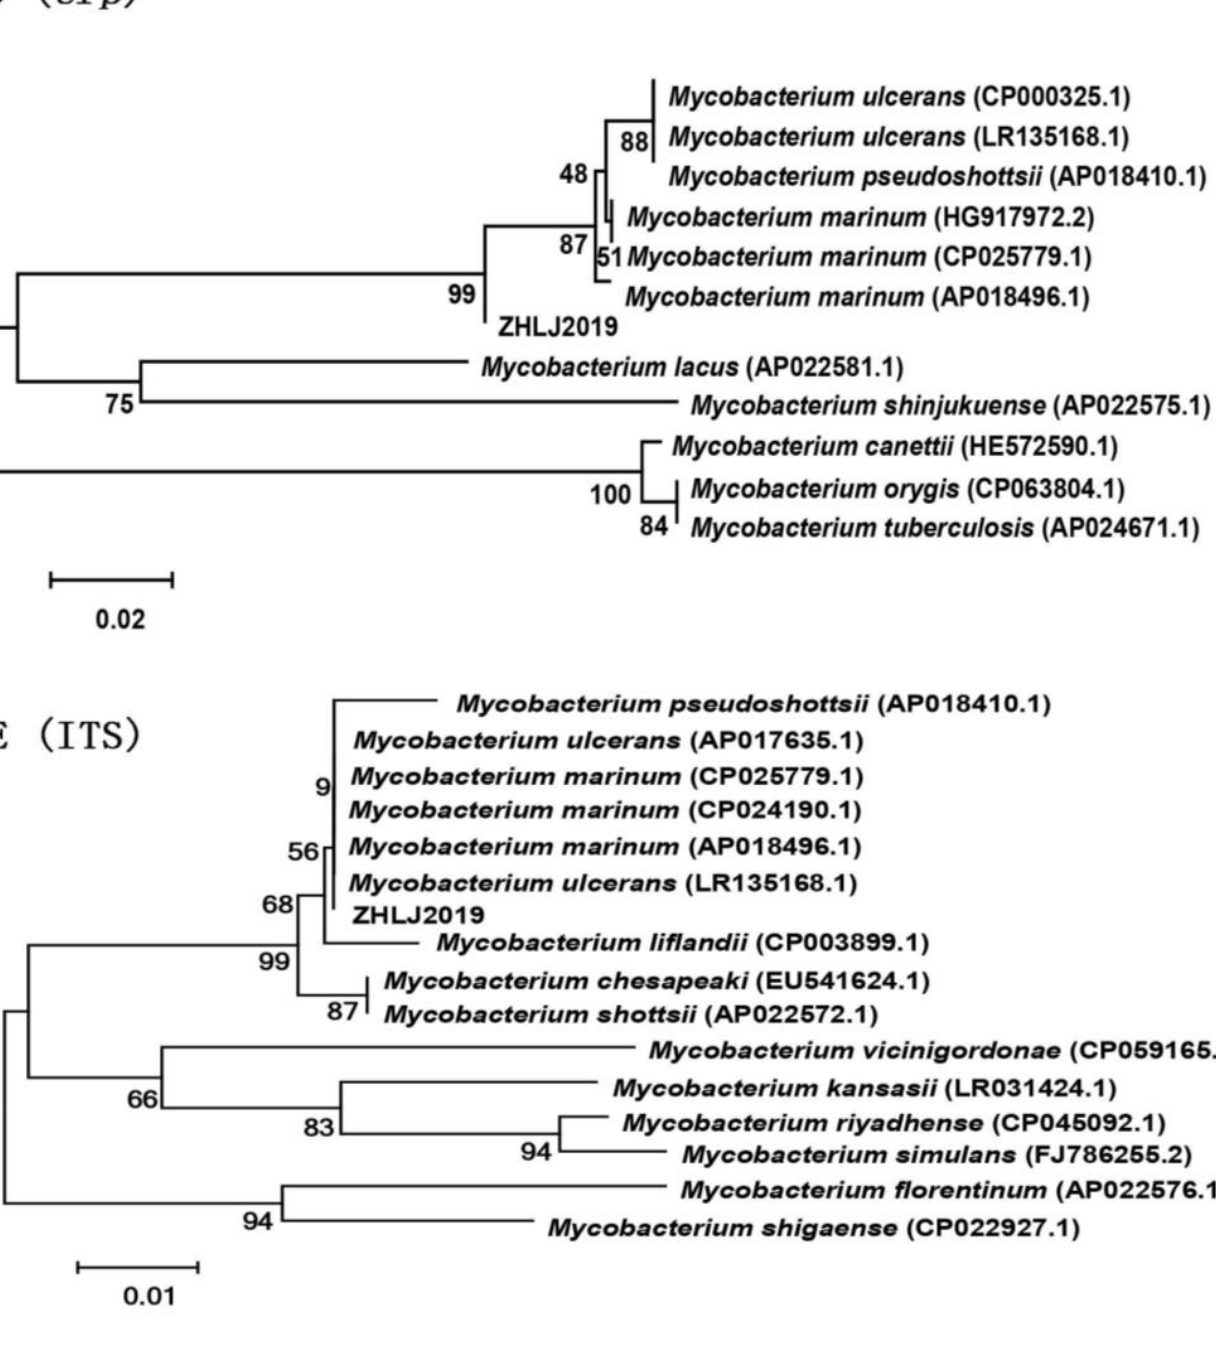
Figure 3. Phylogenetic trees based on the Mycobacterium 16S rRNA ( A ), rpoB ( B ), hsp65 ( C ), erp ( D ), and ITS ( E ) sequences by using the neighbor-joining method. Numerical values in the tree represent bootstrap results.